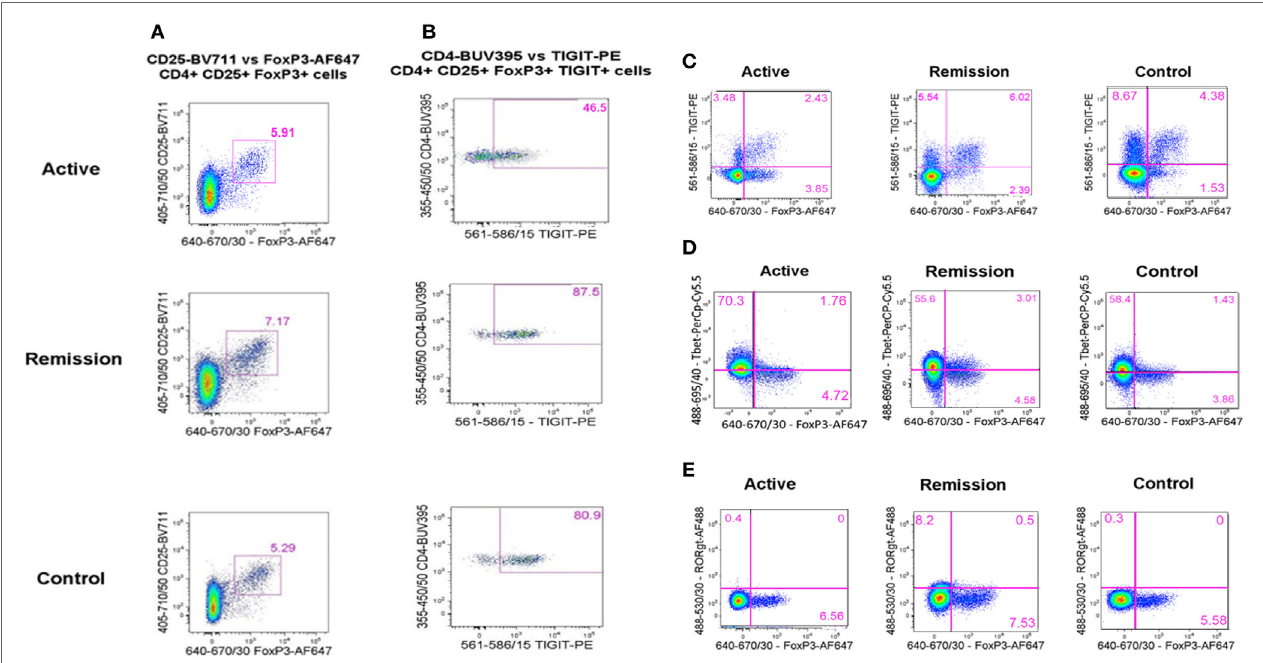
FigUre 5 | Flow cytometry analysis plots showing representative examples of peripheral blood levels of T-regulatory cell (Treg) subtypes in the CD3 + CD4 + T-cell compartment, across the three subject groups (active, remission, and controls). (a) % CD25 + FoxP3 + Treg. (B) % TIGIT + Treg in the (above) CD25 + FoxP3 + Treg subset. (c) % FoxP3 + TIGIT + Treg (upper right quadrant) and TIGIT + FoxP3 − T-cells (upper left quadrant). (D) % FoxP3 + T-bet + Treg (upper right quadrant). (e) % FoxP3 + ROR γ t + Treg (upper right